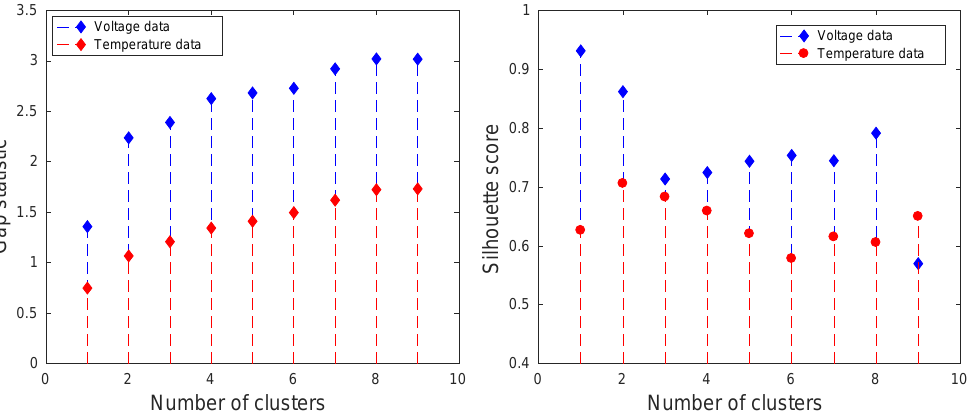
Figure 11. The gap statistic ( left ) and the silhouette score ( right ) of the obtained clustering solutions of reduced data that are measured during discharging